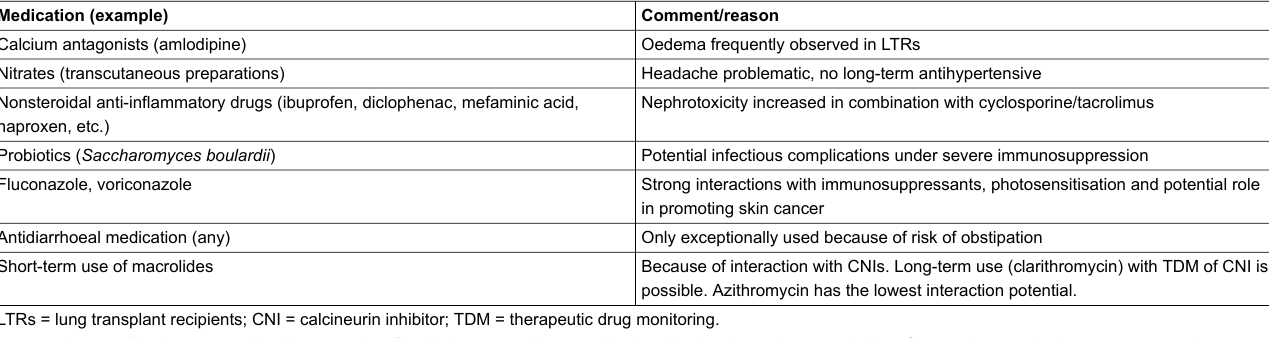
Table 1: Inappropriate medication for early postoperative treatment of lung transplant recipients. Medication